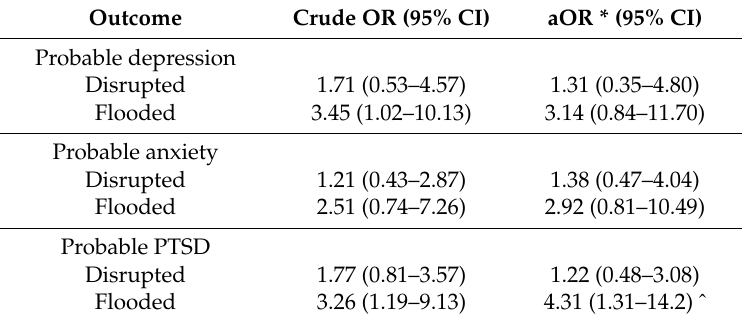
Table 2. Crude and adjusted odds ratios (ORs) or psychological morbidity amongst disrupted and flooded participants, comparing those who did not have insurance at the time of flooding with those who